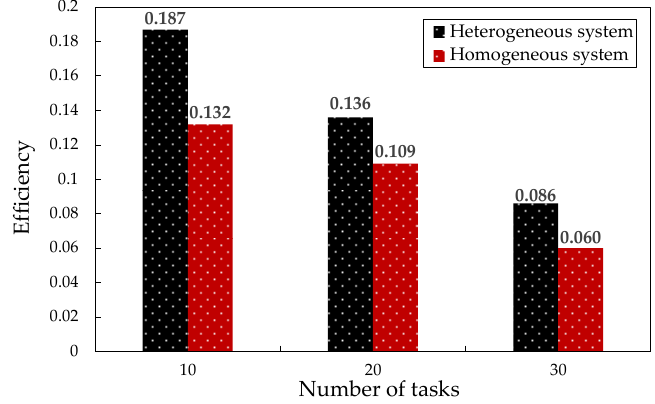
Figure 13. Scheduling efficiency of different processing systems.